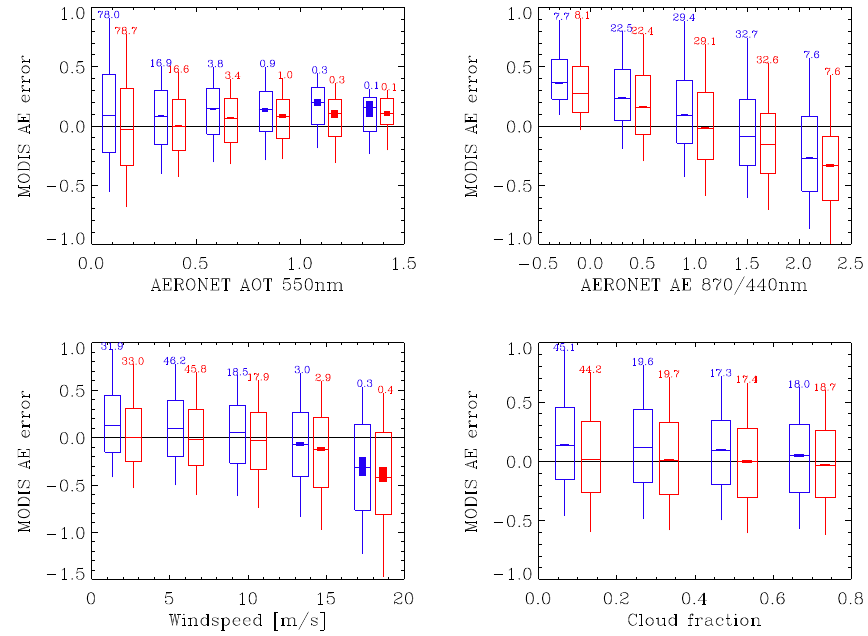
Fig. 5. MODIS AE error statistics as a function of AERONET AOT, AERONET AE, NCEP-DOE-II wind speed and MODIS cloud fraction (blue: Aqua; red: Terra). The box–whisker plots are offset from these bin centres to show the two distributions side by side. Numbers above the box and whisker show the percentage of the total sample used in that